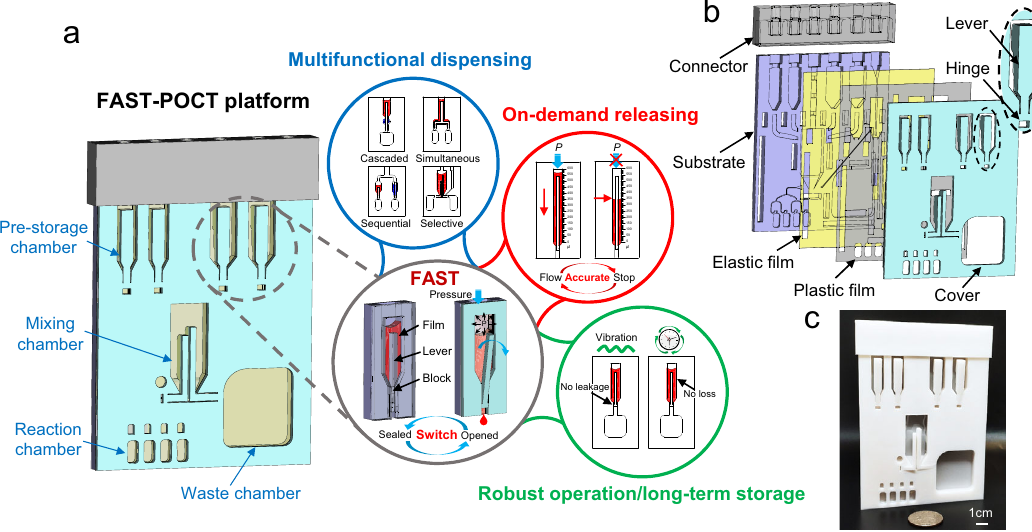
Fig. 1 | Schematic illustration of FAST-POCT platform. a Schematic diagram of the platform with illustration of different functional chambers and the features of